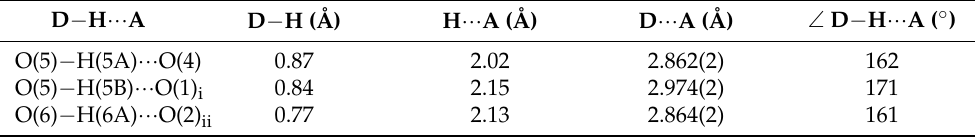
Table 2. Structural parameters of π−π stacking interaction.